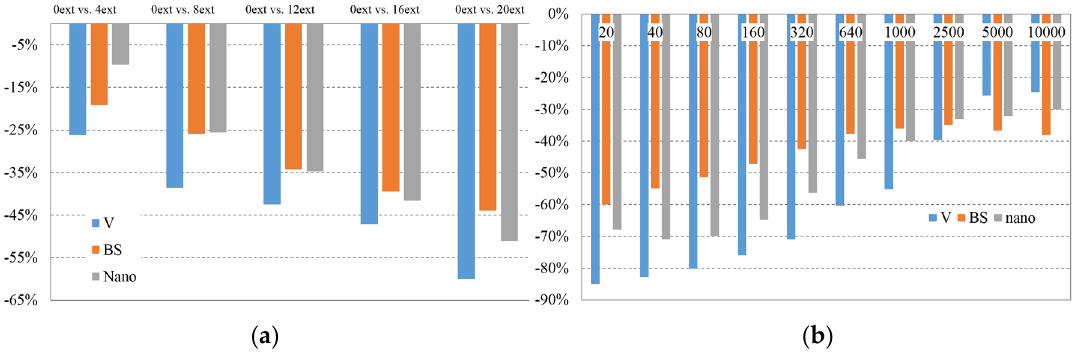
Figure 8. ( a ) Average Variation of Viscosity value @ 190 °C by extrusion batch (compared versus 0 extrusions batch); ( b ) Viscosity value variation by shear rate [compared 0 extrusions versus 20 extrusions batch] @ 190 °C.